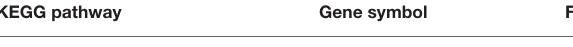
TABLE 1B | CBD suppressed the expression of genes belonging to the NOD-like receptor signaling pathway. KEGG